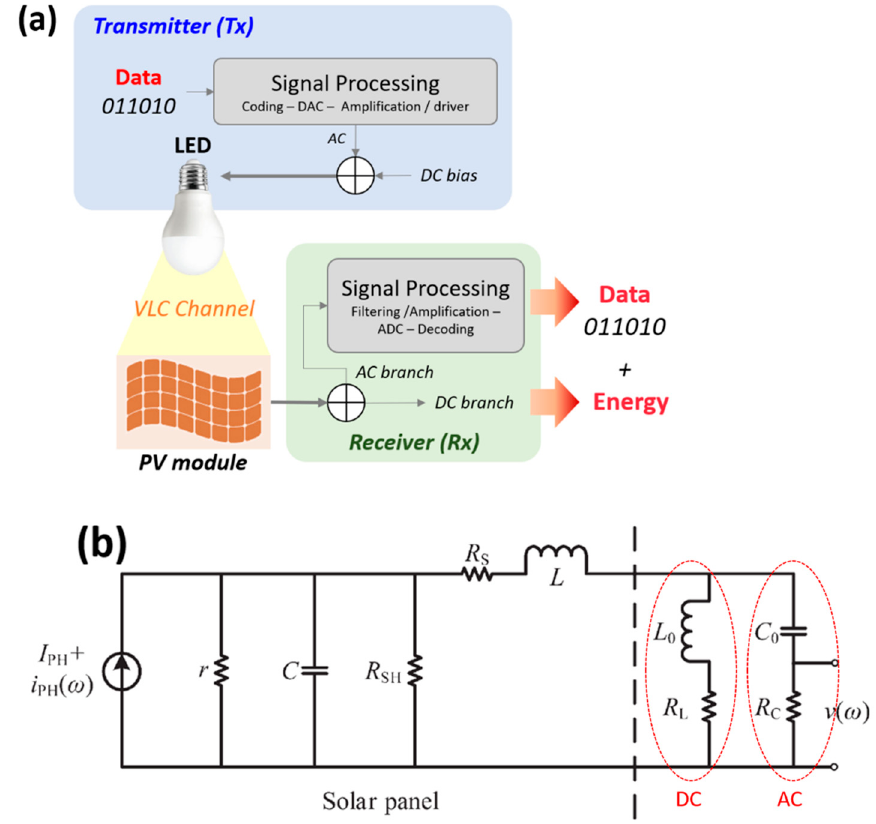
Figure 2. ( a ) Schematic representation of a typical VLC chain illustrating the dual operation of a PV module used as a receiver for simultaneously harvesting energy and optical data from modulated light; ( b ) Equivalent electrical circuit of a solar panel working in dynamic regime and connected to a receiver circuit enabling the reception of both electrical DC and AC components. Modified with permission from reference [63].